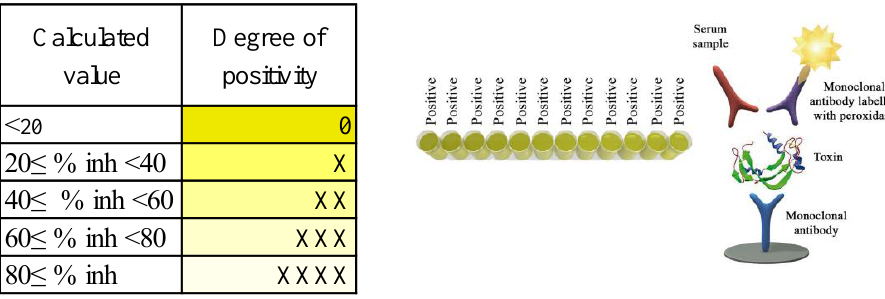
Figure 1. Levels for assessing serum sample positivity.